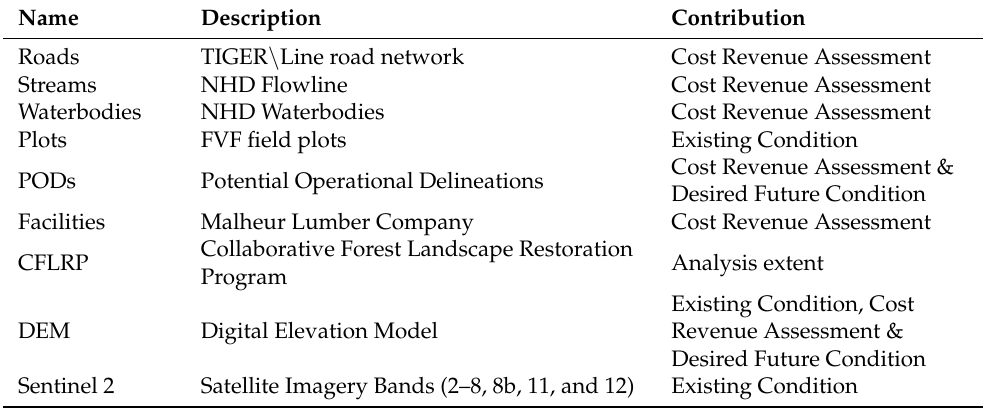
Table 1. A short list, description, and contribution of input